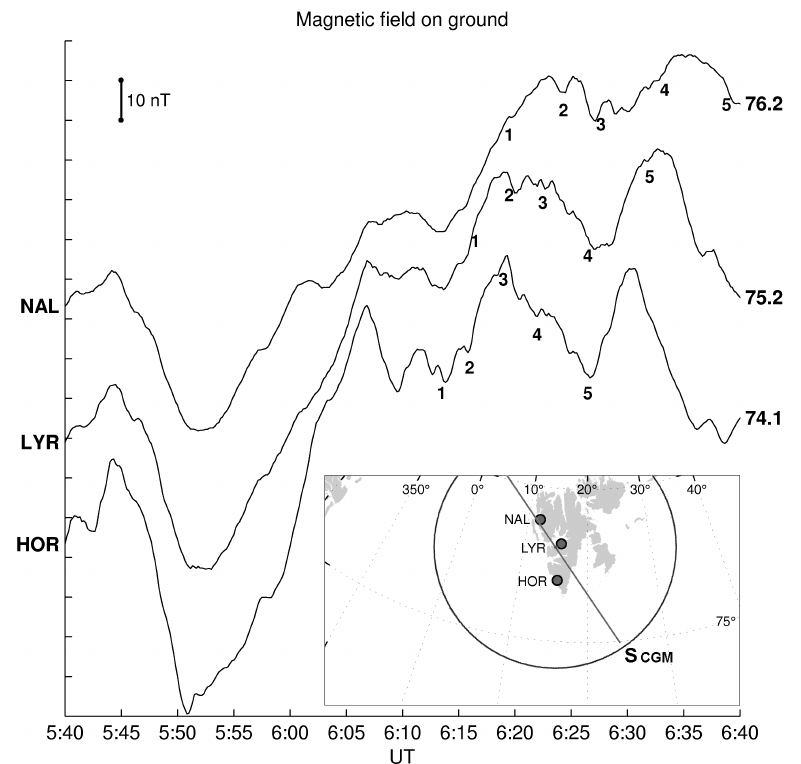
Fig. 7. Ground magnetic data from three observatories, Hornsund, Longyearbyen, and Ny ˚Alesund, of the IMAGE magnetometer network. Geomagnetic (CGM) latitudes of the observatories are indicated on the right side. Figures at the magnetograms indicate times when the arcs with corresponding numbers (Fig. 5) were located at CGM latitude of given